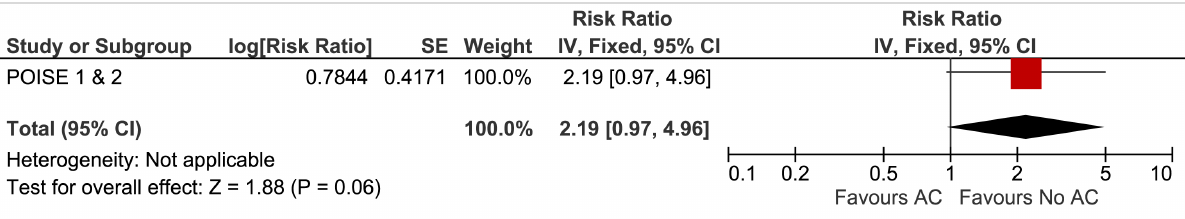
Supplemental figure S3. Forest plot for myocardial